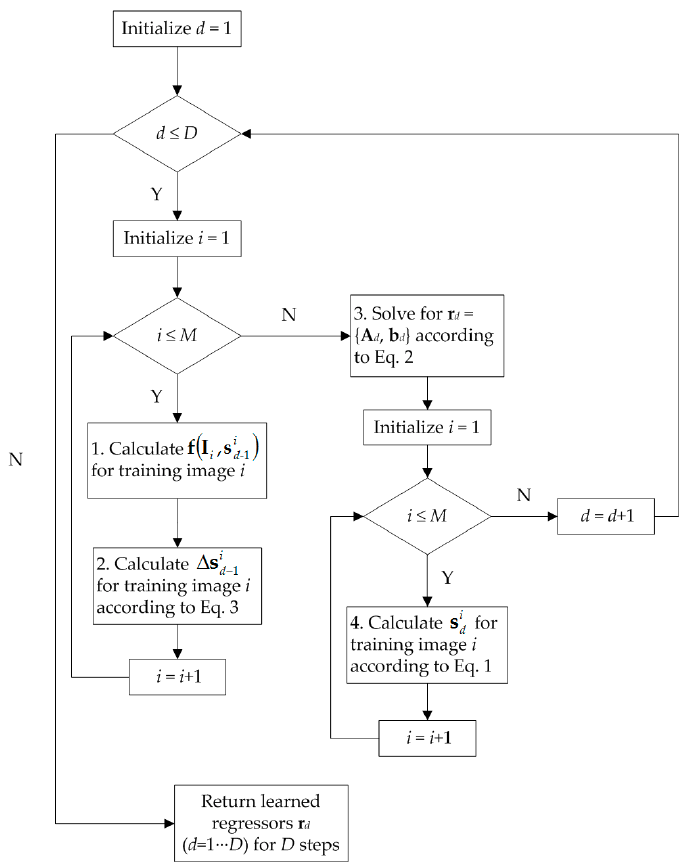
Figure 3. The flow chart of the training algorithm of SDM.